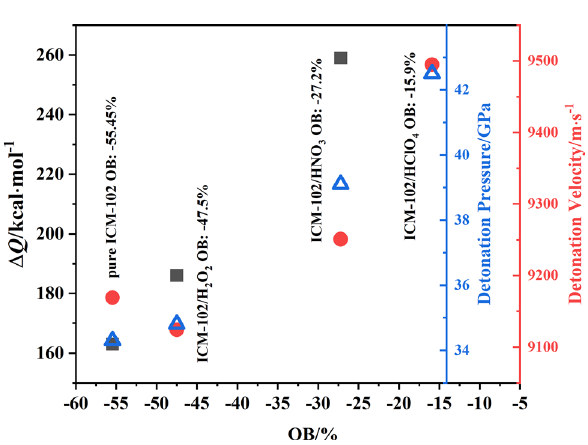
Figure 3. Comparison of the heat release (at 3000 K) and detonation pressure/velocity values of the different host–guest